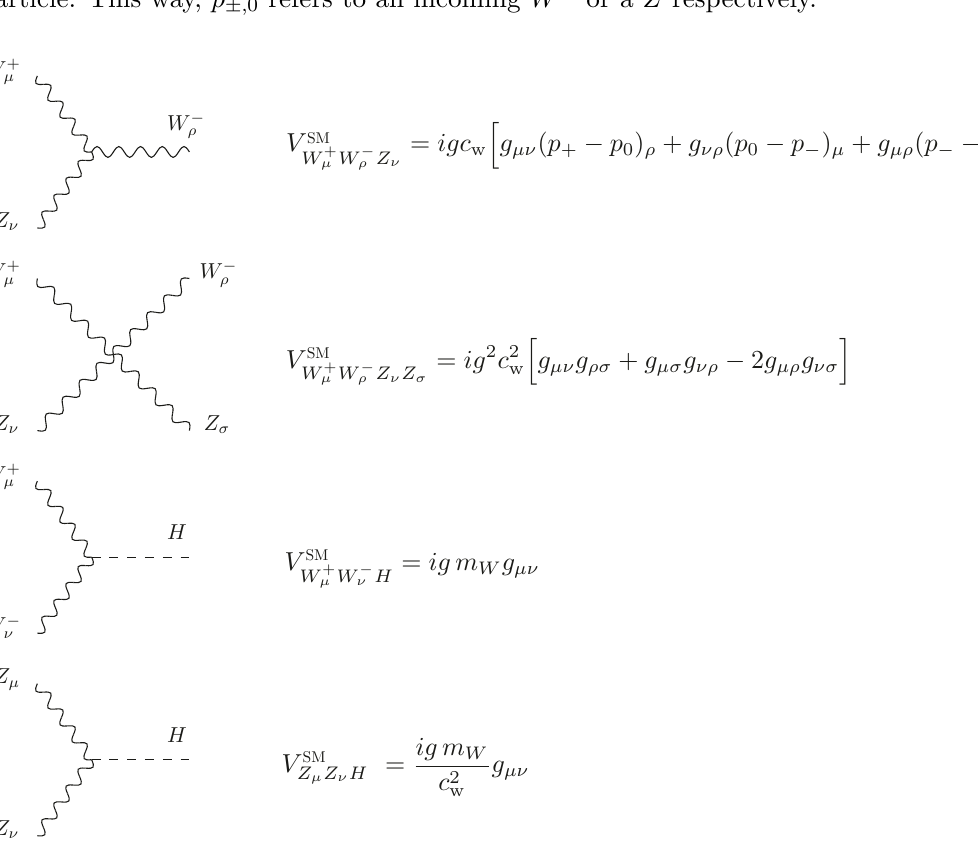
WZ process in the SM. We take all momenta !